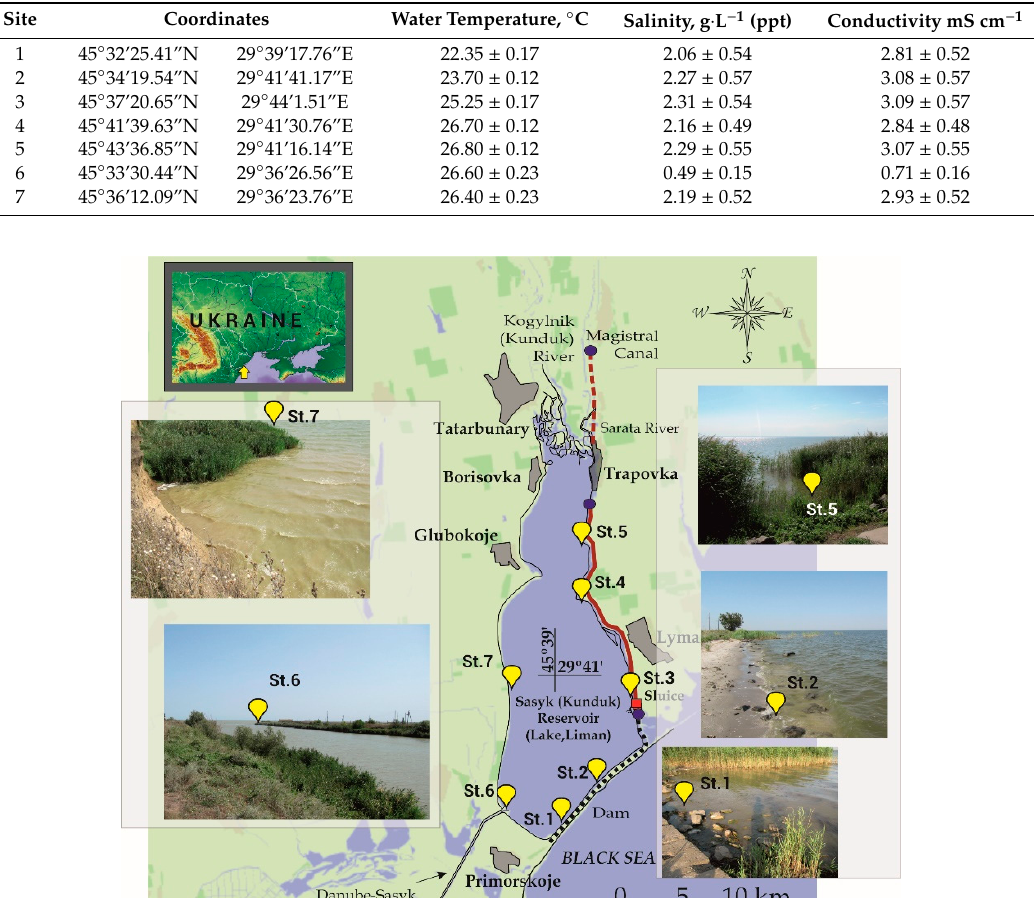
Table 1. Mean environmental data showing standard deviation (SD) and GIS coordinates from the sampling points on the Sasyk Reservoir during August 2018.